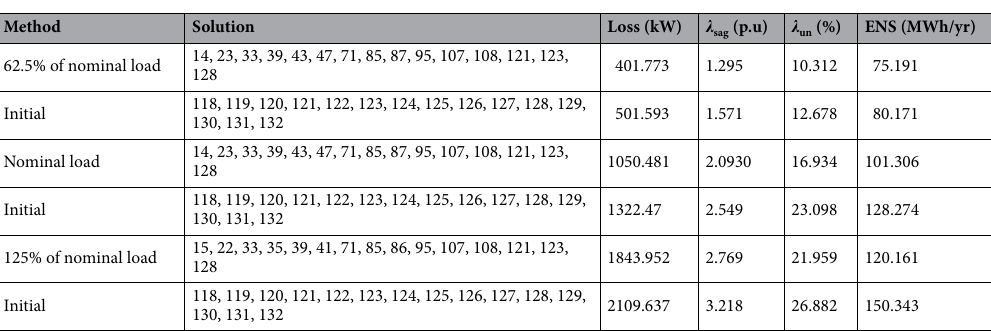
Table 10. Effect of changing the demand for the multiobjective problem of the unbalanced 118-bus network via ITSOA.